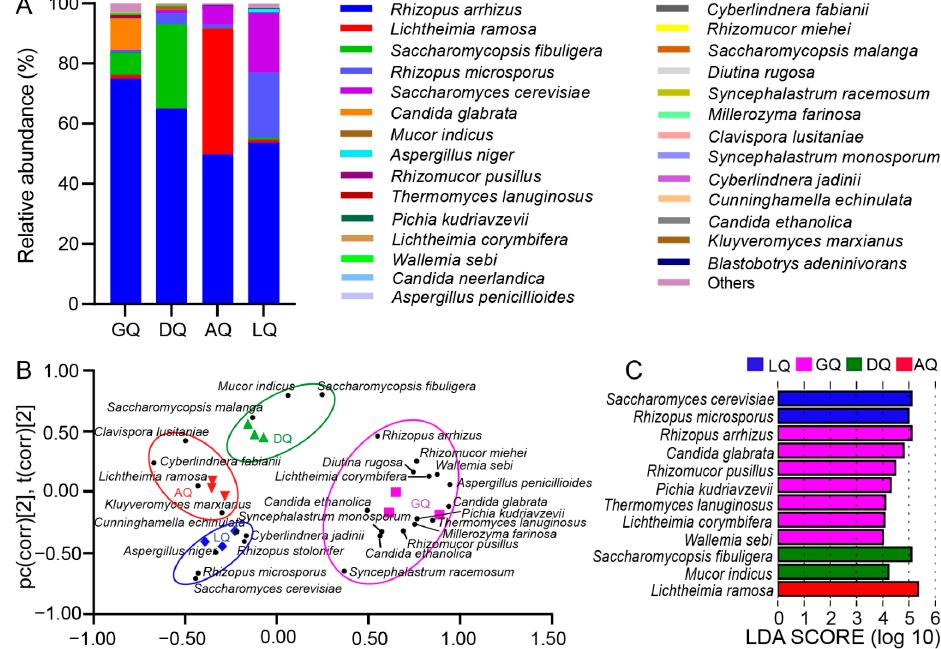
Figure 3. Analysis of fungal species composition in different geographical Qu. ( A ) Relative abundance of fungal species identified in different Qu. ( B ) Partial least squares discriminant analysis